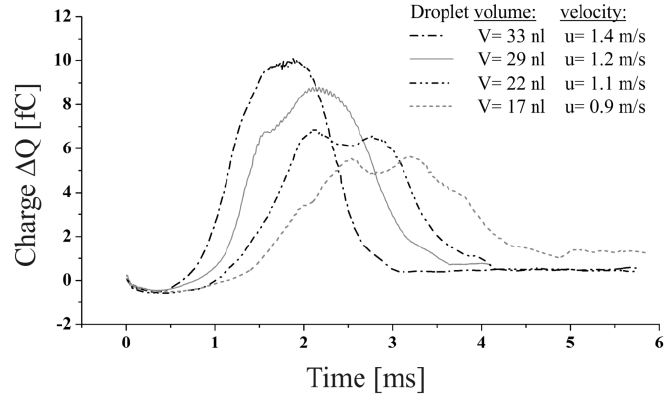
Figure 9. Charge alternation caused by dispensed droplets of different volumes and velocities.